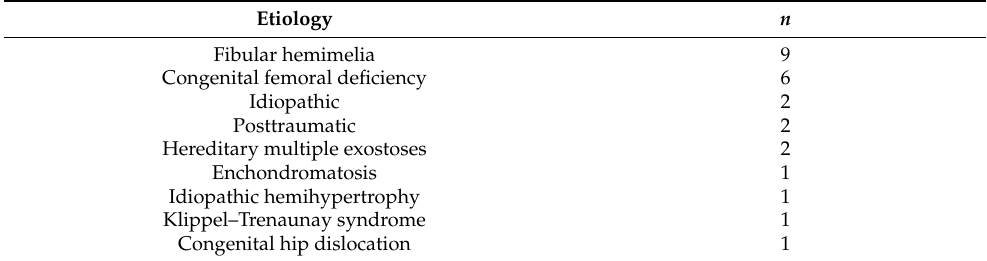
Table 1. Underlying conditions.